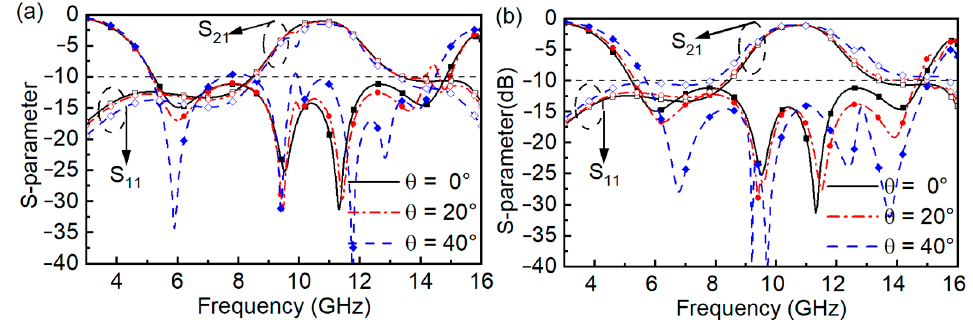
Figure 8. Simulated results of oblique incident. ( a )TE polarization. ( b )TM polarization.